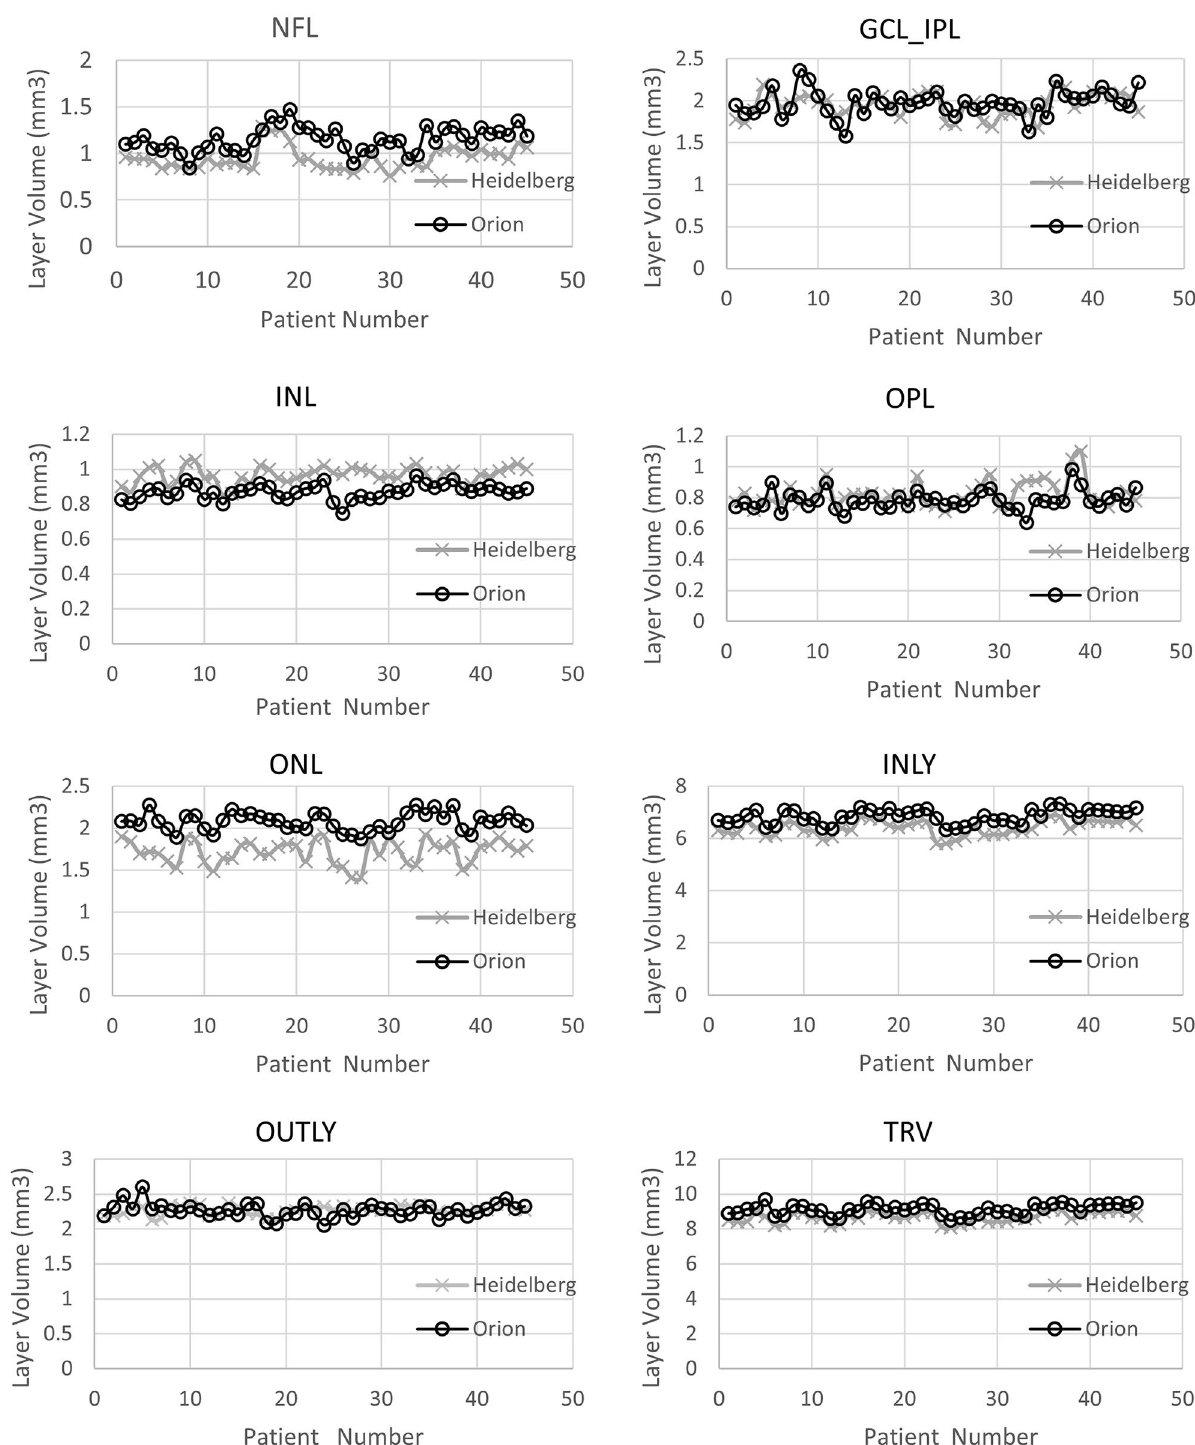
Figure 2. Comparison of retinal layer volumes between proprietary and cross-platform softwares in normal